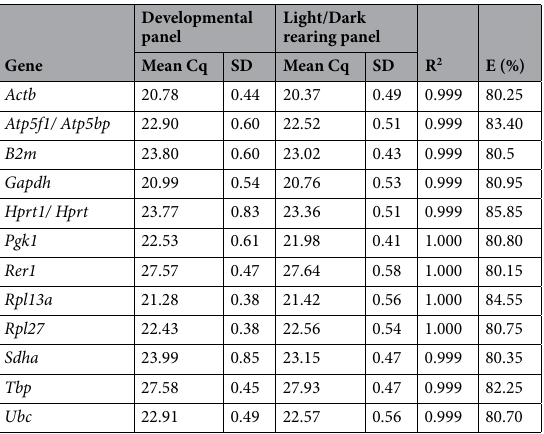
Table 2. Descriptive statistics of Cq values and qPCR reactions. SD: standard deviation; R 2 : coefficient